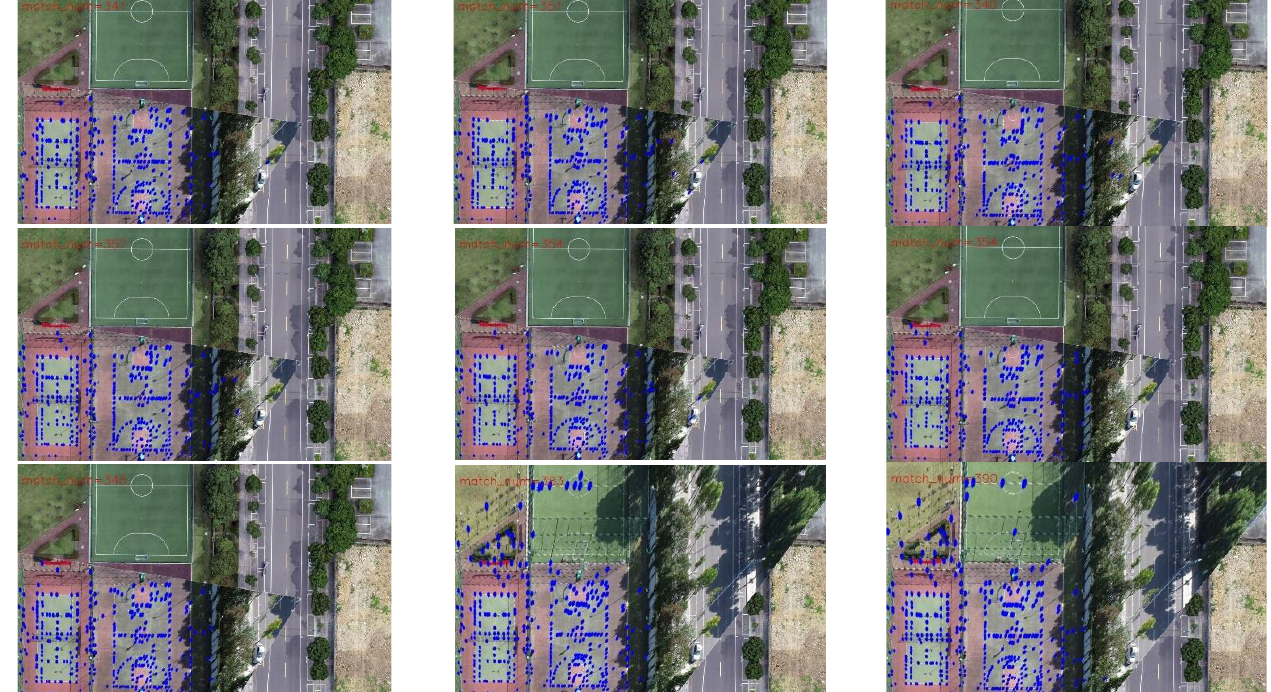
Figure 20. Registration image (after updating the map features).